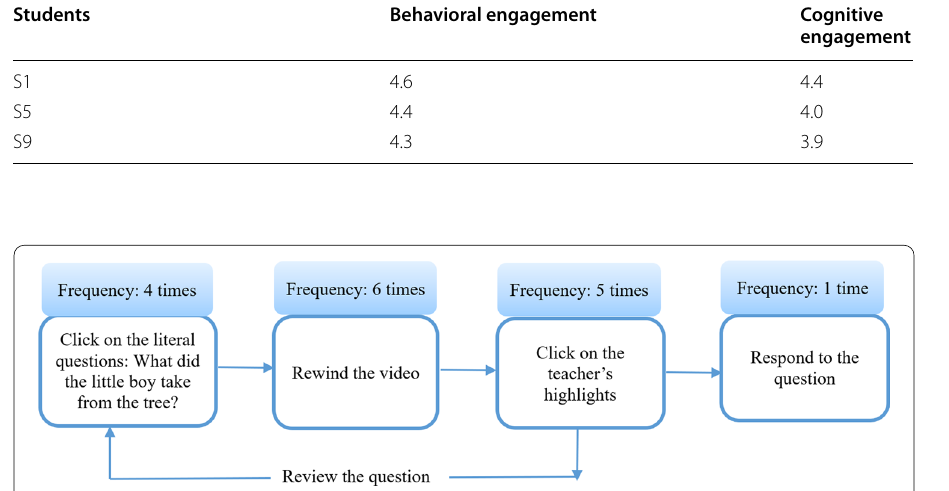
Fig. 3 S1 ′ s learning path following the literal